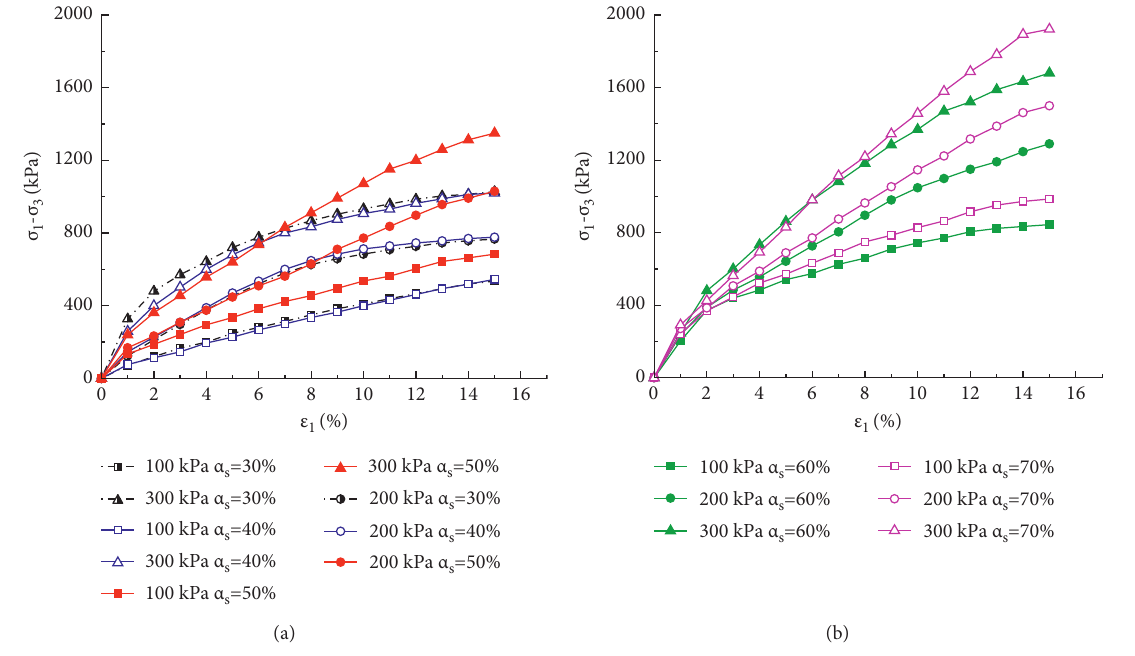
Figure 6: Relationship between principal stress difference and axial strain ( ω � 50%).